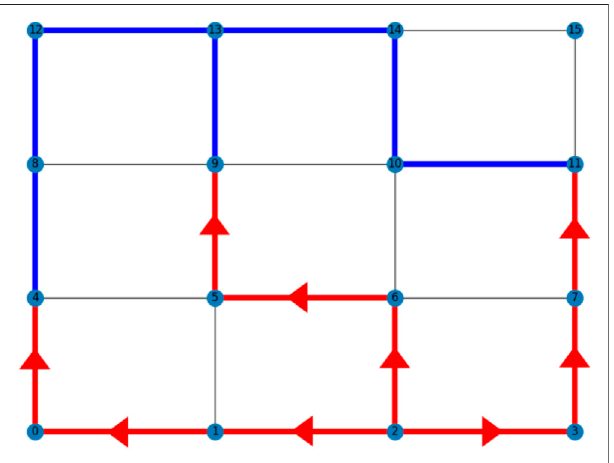
FIGURE 7 | Example grid state for a 4 × 4 square lattice.